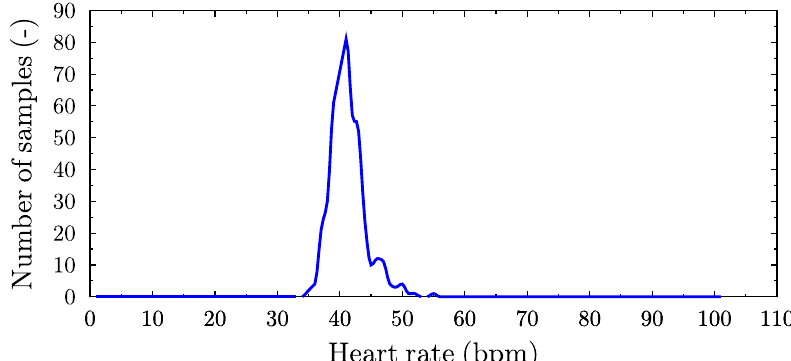
Figure 6. The final form of the signal subjected to Continuous Wavelet Transform